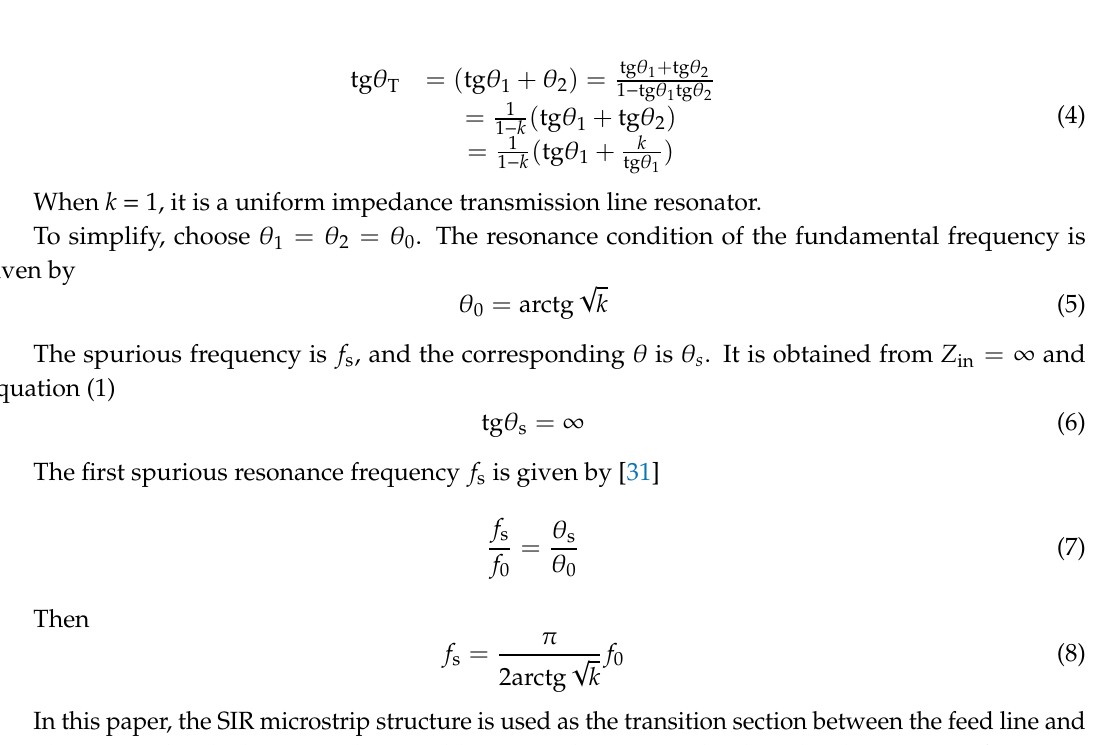
Freq/GHz Figure 4. Simulation results of the reflection coefficient of the rectangular microstrip patch antenna. In order to expand the bandwidth and to make a good transition between the radiation patch and the feed line, the SIR microstrip structure is added between the radiating patch and the feed line. Figure 5 shows the simulation curve of the antenna reflection coefficient with SIR structure. The operating frequency band is from 2.4 GHz to 11.29 GHz, with a reflection coefficient of less than −10 dB. The bandwidth is 8.89 GHz. Two zero points appear in the passband. The bandwidth is increased, and the characteristics are improved in the band. To further broaden the operating band and improve the characteristics in-band, two symmetric L-shaped slots are implemented on the side of the rectangular patch. The simulation curve of the reflection coefficient is shown in Figure 6. The frequency is from 2.78 GHz to 13.16 GHz, while the reflection coefficient is less than −10 dB. The bandwid th is broadened by 10.38 GHz so far. Continuously, two symmetric I-shaped slots are implemented on the side of the SIR microstrip near the feed line. Figure 7 shows the simulation results of the reflection coefficient. It can be seen that the frequency band from 2.64 GHz to 13.93 GHz shows a small reflection coefficient of less than −10 dB. In this manner, the bandwidth is broadened by 11.29 GHz, with obvious improvements on the characteristics.